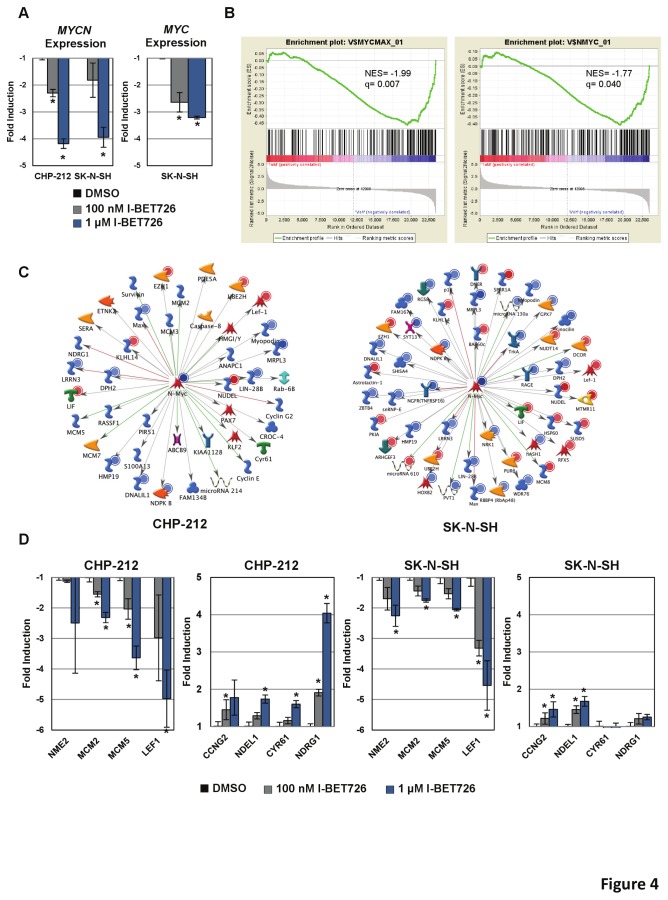
Global transcript profiling reveals gene expression changes in MYC-family pathways.(a) qRT-PCR confirmation of changes in MYCN and MYC expression following treatment with the indicated concentration of I-BET726. Data represent mean value ± standard deviation for three independent biological replicates. Asterisks indicate statistical significance as measured by t-test (p <0.05). (b) GSEA enrichment plots showing the down-regulation of gene sets associated with Myc/Max and N-Myc binding motifs in I-BET726-treated CHP-212 cells. Normalized enrichment scores (NES) and FDR q values are indicated. (c) A MYCN transcriptional regulation network was constructed (see Materials and Methods) to depict N-Myc pathway genes that were modulated by I-BET726 treatment. Red and blue circles represent increased and decreased expression changes, respectively. Green, red and grey edges are shown for activation, inhibition and unspecified interaction types, respectively. (d) qRT-PCR confirmation of a subset of genes selected from the N-Myc network analysis described in (c). Data presented as described in (a).